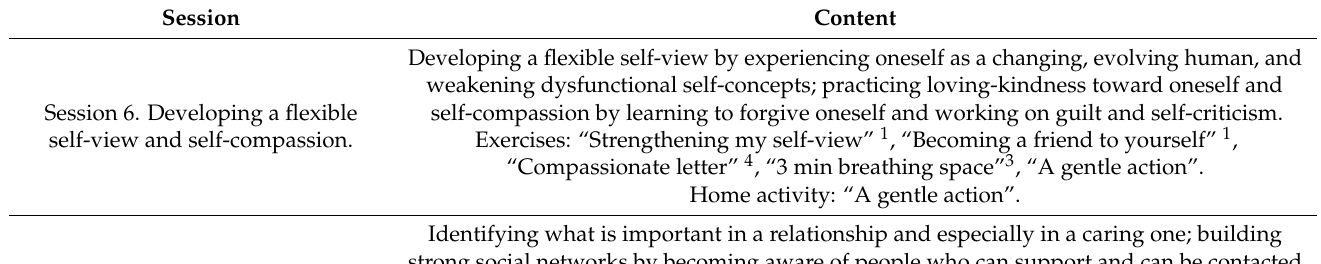
Session 7. Building strong